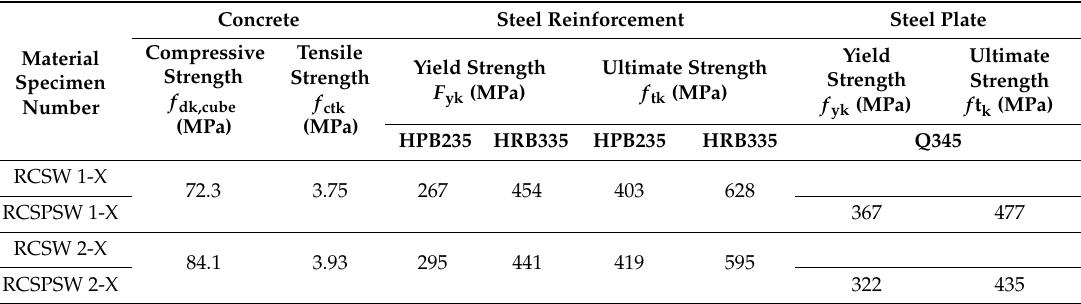
Table 2. Material